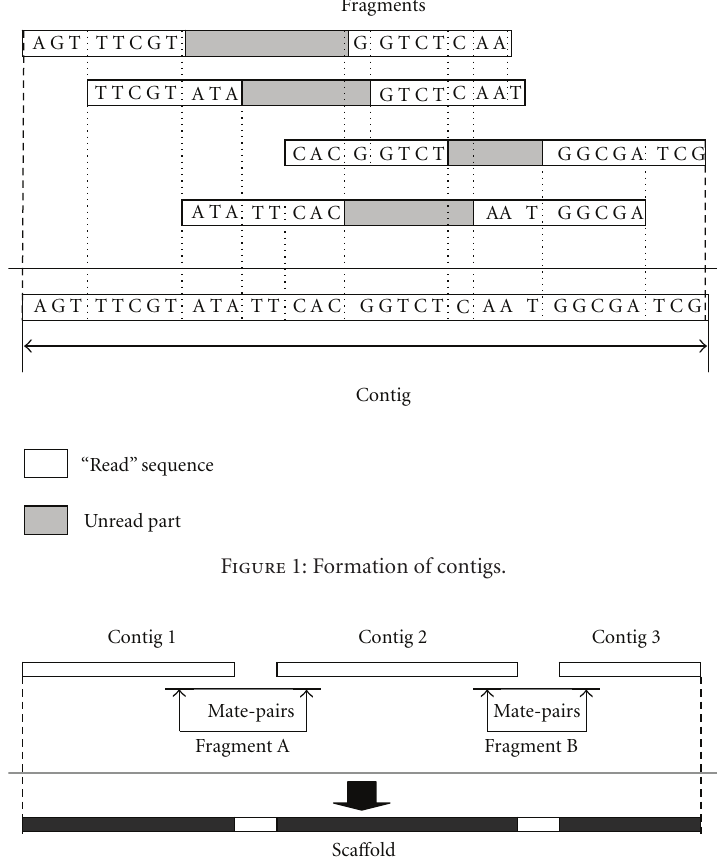
Figure 2: Sca ff